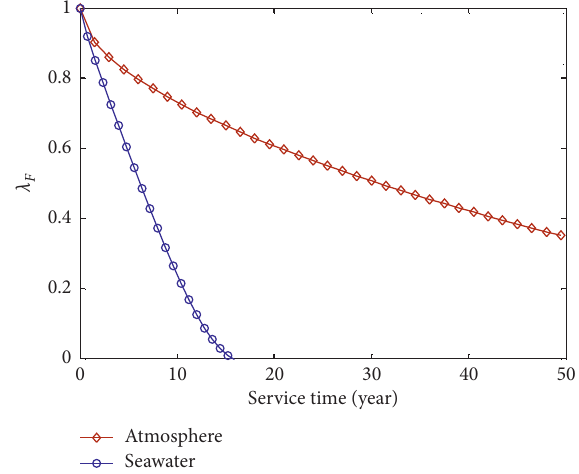
Figure 14: The degradation of tensile capacity with an increase of pipe service